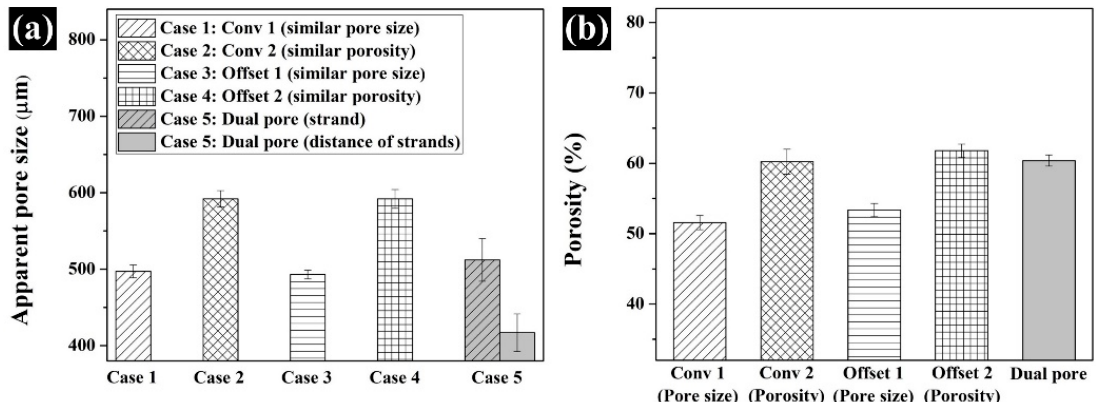
Figure 3. Three-D modeling, top-view, and side-view images of the fabricated scaffolds: ( a ) Conv 1 (similar pore size); ( b ) Conv 2 (similar porosity); ( c ) Offset 1 (similar pore size); ( d ) Offset 2 (simi- lar porosity); ( e ) dual pore.